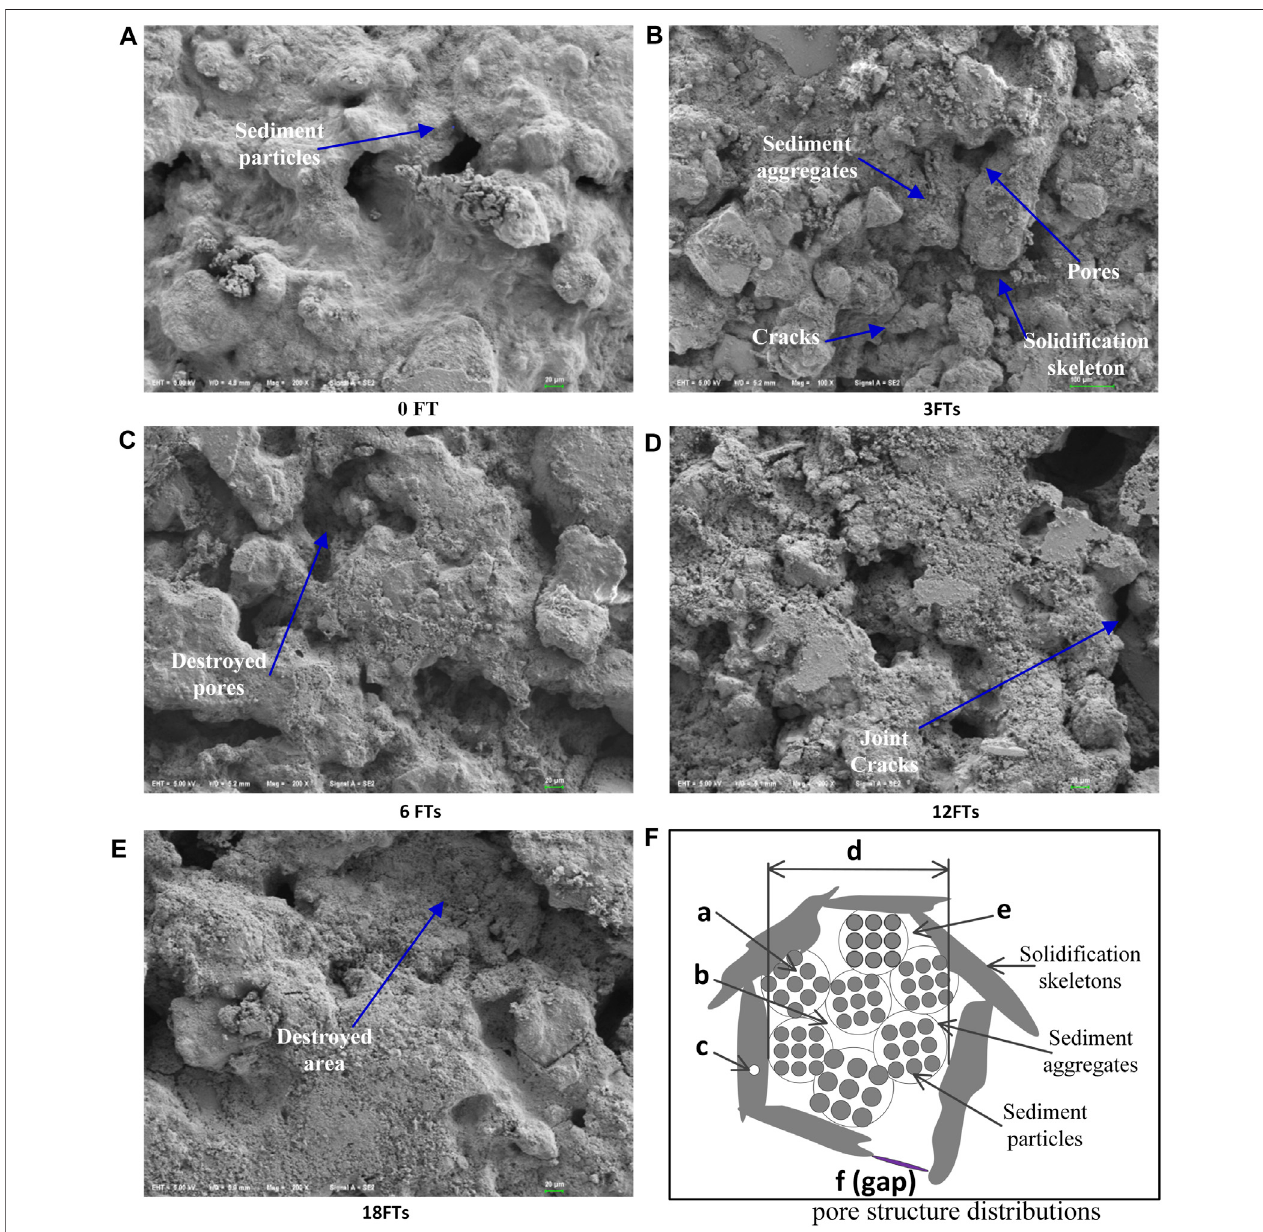
FIGURE 7 | Microstructures of S/S sediments in FTs: (A) 0 FT, (B) 3 FTs, (C) 6 FTs, (D) 12 FTs, (E) 18 FTs, (F) pore structure distributions.